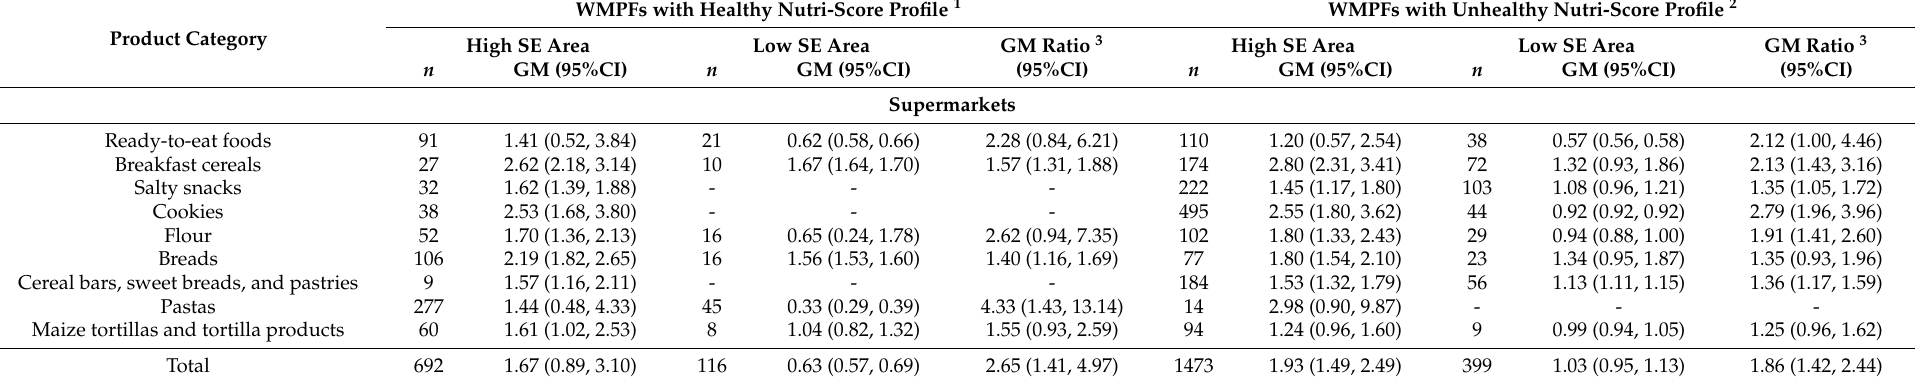
Table 4. Geometric mean price (per 100 g) for wheat and maize processed foods (WMPFs) across Nutri-Score profile in food retail outlets and by socioeconomic (SE)